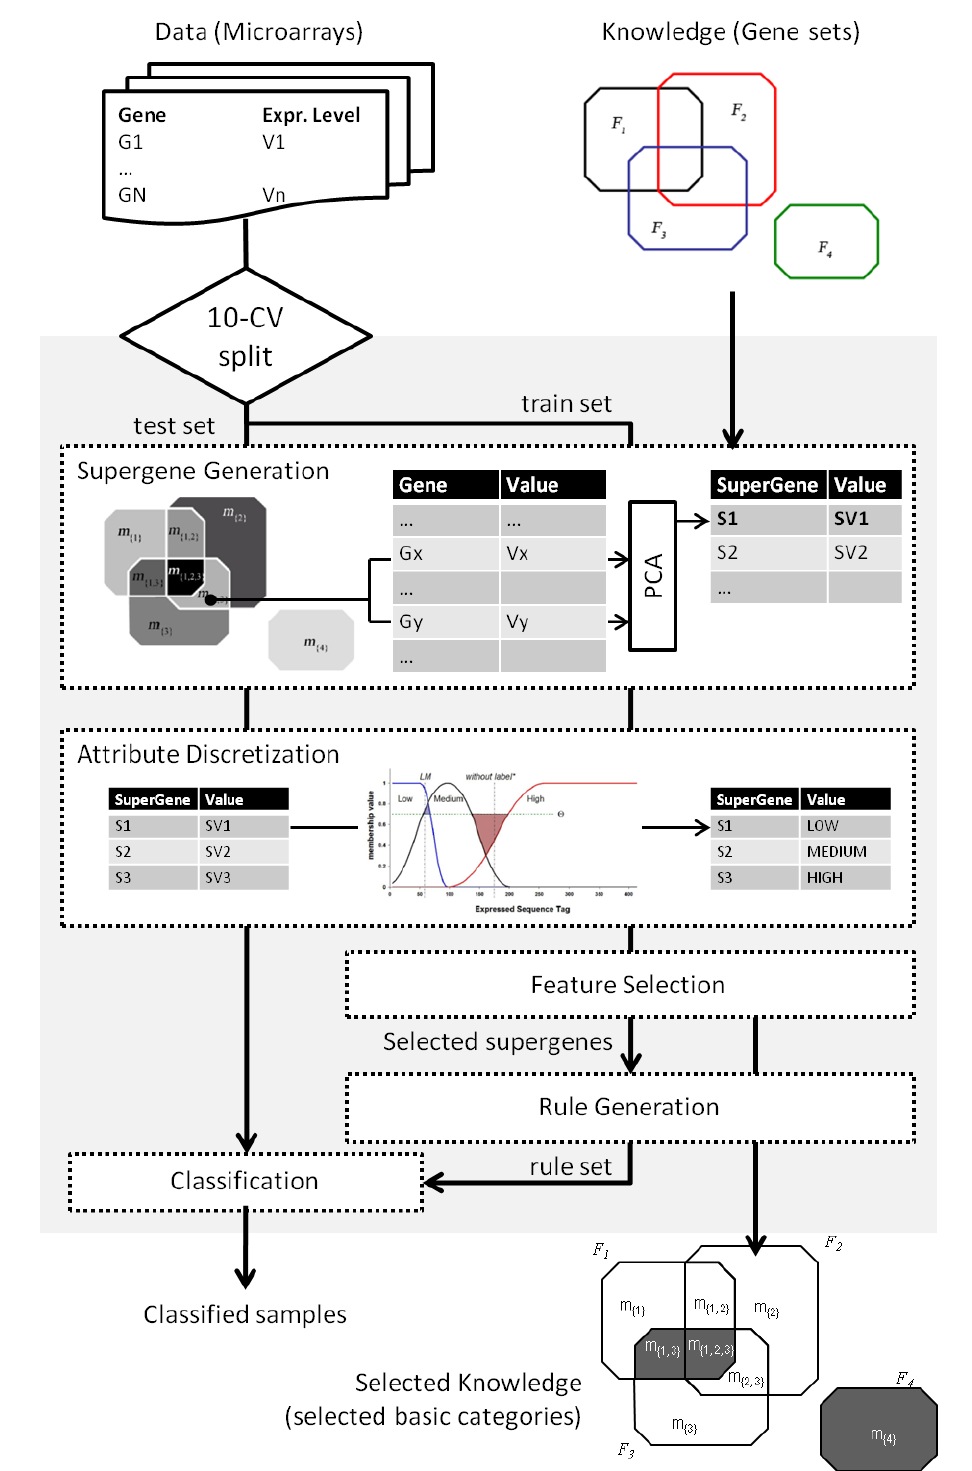
Figure 1: Classification